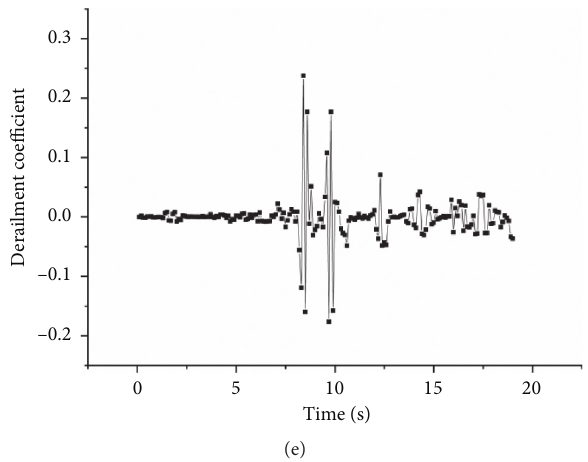
Figure 17: Wheel-track-subgrade time history under the Tianjin wave. (a) Lateral acceleration-time curve of the wheel. (b) Lateral force- time curve between the wheel and rail. (c) Vertical force-time curve between the wheel and rail. (d) Wheel load reduction rate-time curve. (e) Derailment coefficient-time